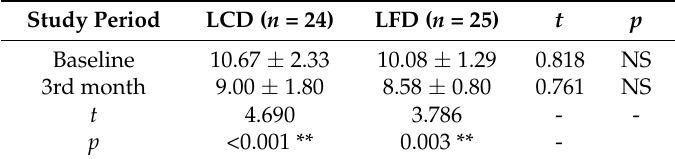
Table 7. Comparison of postprandial 2-h blood glucose (mmol/L) in the groups.